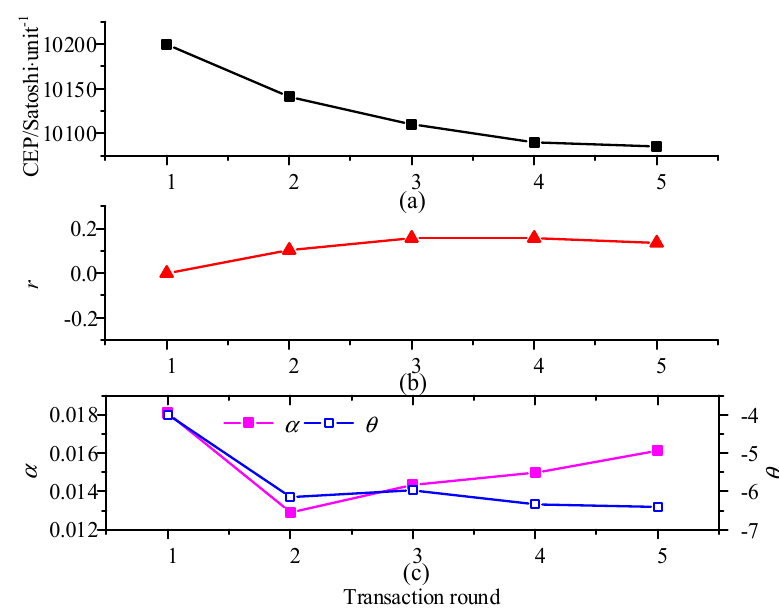
Figure 8. CEP and short- and long-term learning outcomes. ( a ) CEP estimation; ( b ) short-term learning outcome; ( c ) long-term learning outcome.